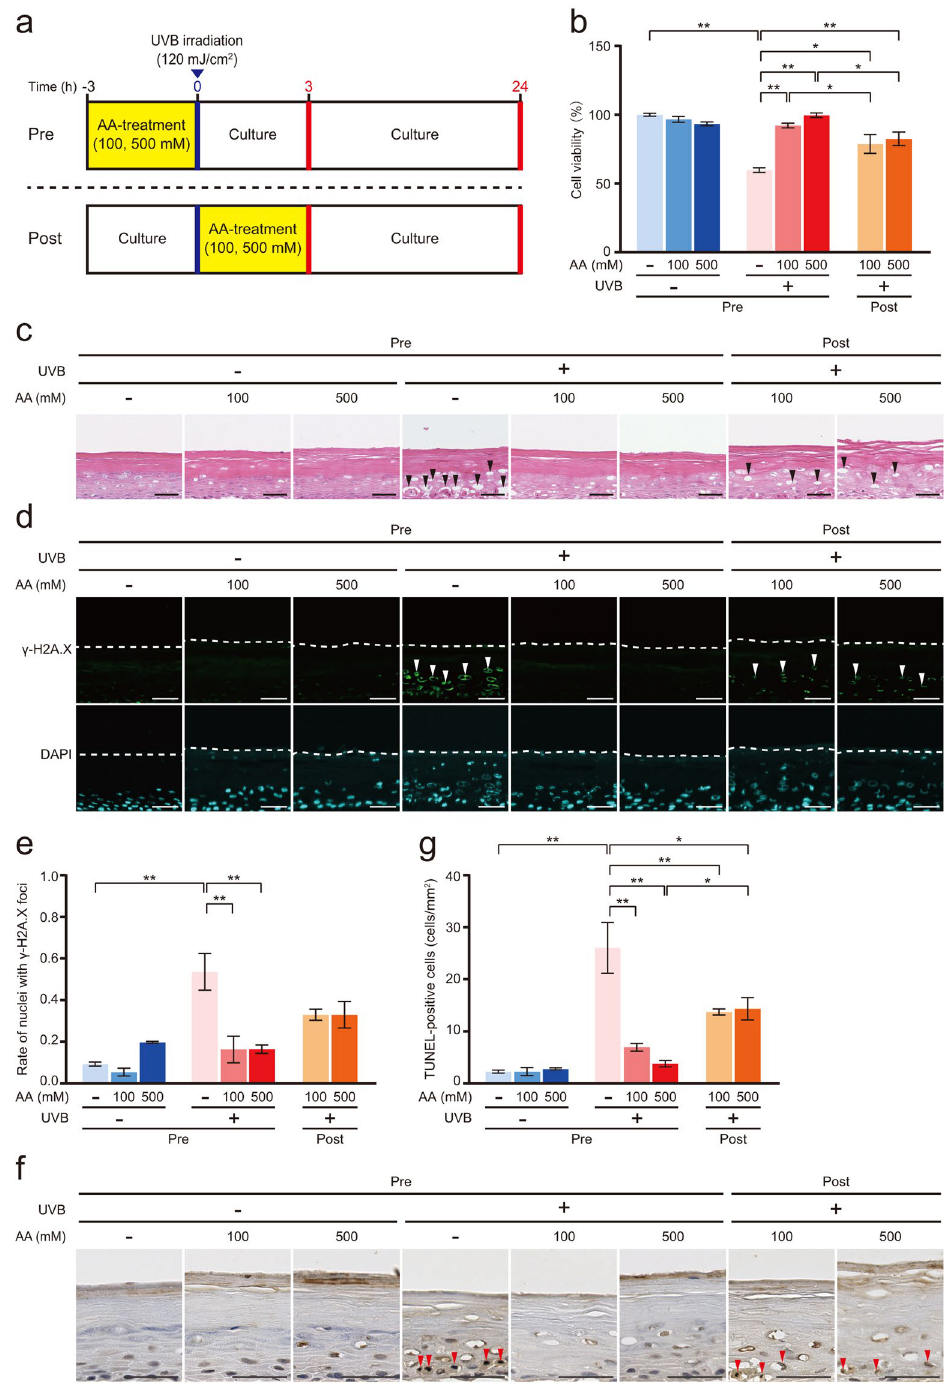
Figure 4. Effect of AA on UVB-induced DNA damage and apoptosis. ( a ) Treatments of 100 and 500 mM AA were applied to the reconstituted human epidermal surface for 3 h before or after 120 mJ/cm 2 UVB irradiation. After UVB irradiation, the epidermis was cultured for 24 h. ( b ) Cell viability was measured using the MTT assay. Values are presented as the means ± SEM of three wells. ( c ) Histology of the epidermis, as detected by HE staining. Black arrowheads indicate gaps formed by holes. Bar = 50 µ m. ( d ) Immunofluorescence staining for γ -H2A.X as a marker of DNA double-strand breaks. The dotted line represents the bottom of the cornified layer. White arrowheads indicate γ -H2A.X-positive nuclei. Bar = 50 µ m. ( e ) The percentage of γ -H2A.X-positive nuclei per DAPI-positive nuclei. Values are presented as the means ± SEM of three wells. ( f ) Apoptotic cells were detected by TUNEL staining. Red arrowheads indicate TUNEL-positive cells. Bar = 50 µ m. ( g ) Number of TUNEL-positive cells under the cornified layer. Values are presented as the means ± SEM of three wells. The statistical analysis was performed using one-way ANOVA followed by Tukey’s post hoc test. * P < 0.05, ** P < 0.01. Pre, AA treatment before UVB irradiation. Post, AA treatment after UVB